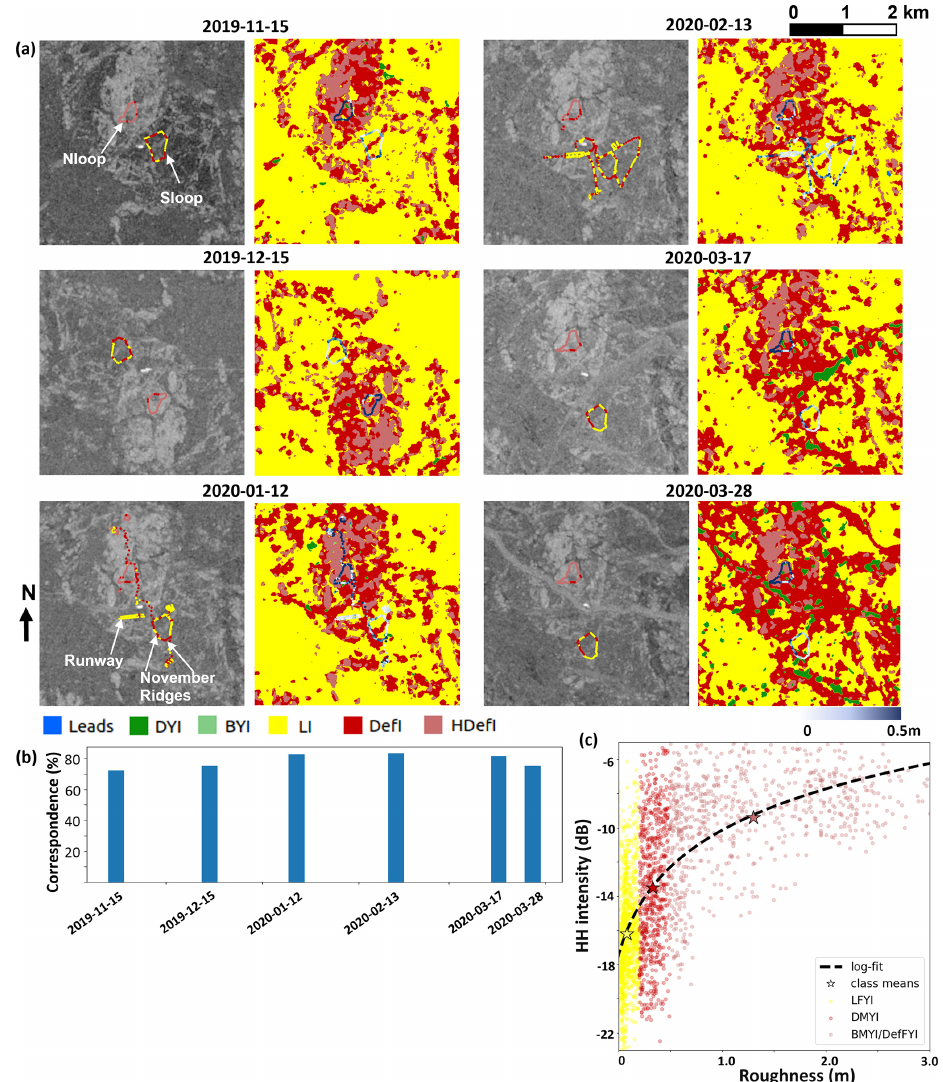
Figure 10. (a) Sea ice roughness in transects (in blue) overlaid on synthetic aperture radar (SAR) classification maps as well as the classi- fication of sea ice roughness (in the same color scheme) overlaid on HH intensities in several transects within a 4km × 4km square around RV Polarstern for the same dates as those shown in Fig. 8; (b) the percentage correspondence between SAR and roughness classifications in repeated transects; and (c) a scatterplot of HH intensities vs. ice roughness in repeated transects, grouped by their corresponding class labels from the SAR